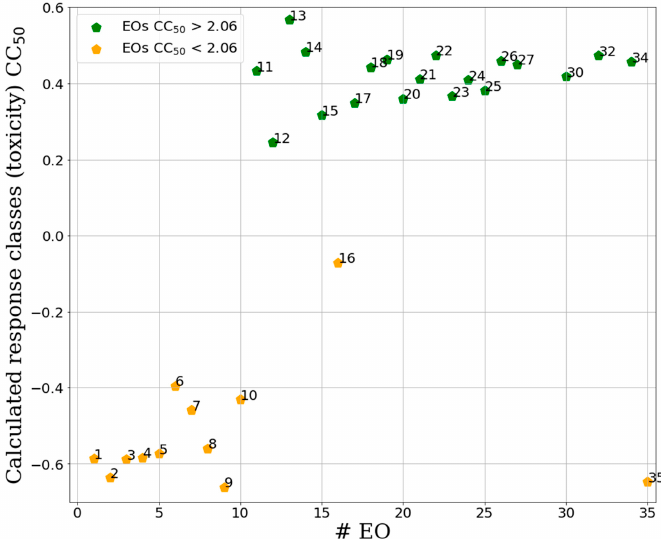
Figure 6. Separation between active and inactive samples for the binary CC 50 -PLS-DA classification model. Green samples are the non-toxic class, orange the toxic. On the y-axis are reported the calculated response for the toxic classis calculated by the PLS-DA technique (X score × Y weights) for each EO [24] (Table 2). Samples at the top of the plot were assigned to be a non-toxic class while those at the bottom were classified as toxic. Molecules 2020 , 25 , x FOR PEER REVIEW